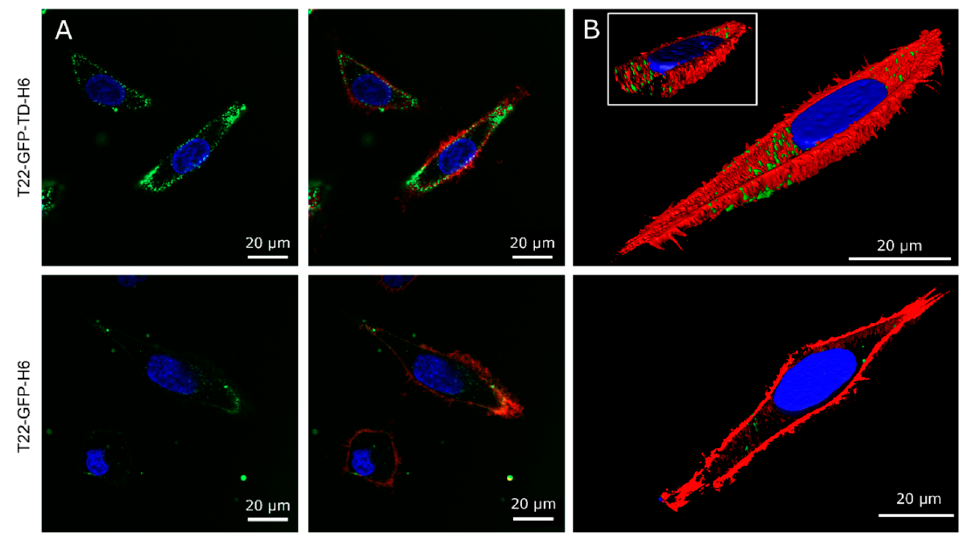
Figure 3. Intracellular distribution of T22 ‐ GFP ‐ TD ‐ H6 and T22 ‐ GFP ‐ H6. ( A ) 2D confocal microscopy images of HeLa cells upon exposure to 1000 nM of T22 ‐ GFP ‐ H6 or T22 ‐ GFP ‐ TD ‐ H6 for 2 h. Red signal indicates labelled membranes, blue signal nuclear nucleic acids and green signal is from the green fluorescent protein. Left panels show green and blue channels of a particular plane, adding the red channel at the right panel. ( B ) 3D reconstructions of confocal stacks along the z ‐ axis, at the same conditions. A clipping plane inset is shown for the represented cell exposed to T22 ‐ GFP ‐ TD ‐ H6, to indicate the distribution of GFP dots inside the cell. Bars indicate 20 μ m.